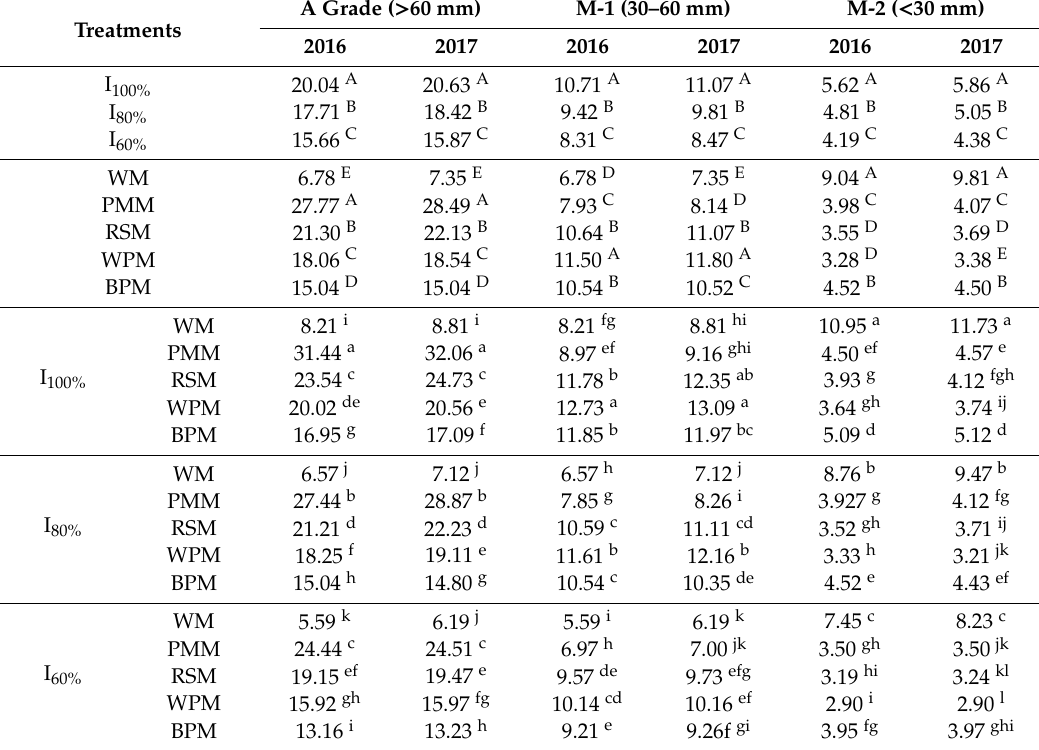
Table 7. E ff ect of irrigation and mulching treatments and their interaction on the size of potato tubers during 2016 and